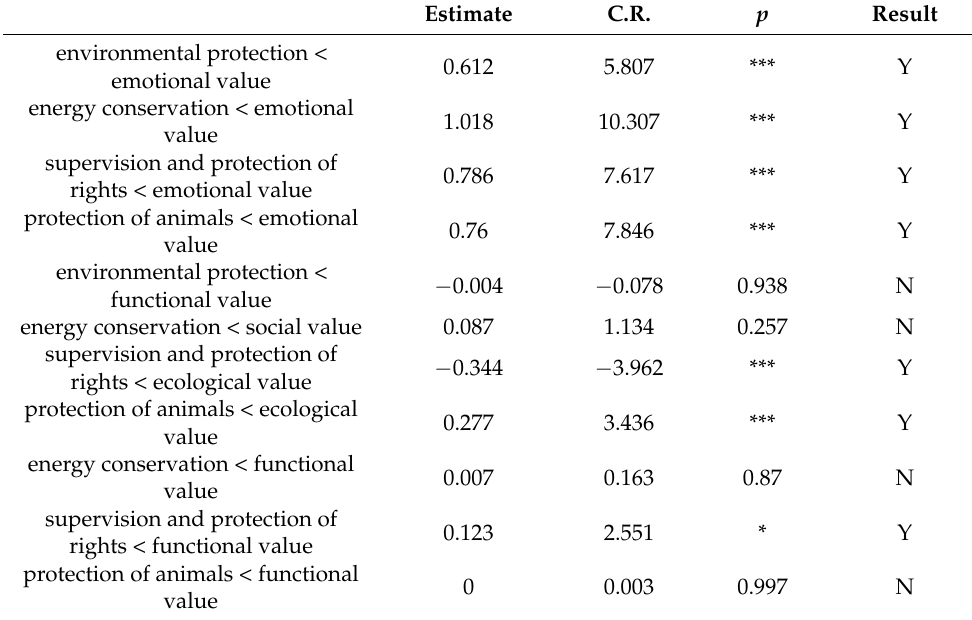
Table 9. Theoretical structural equation model path